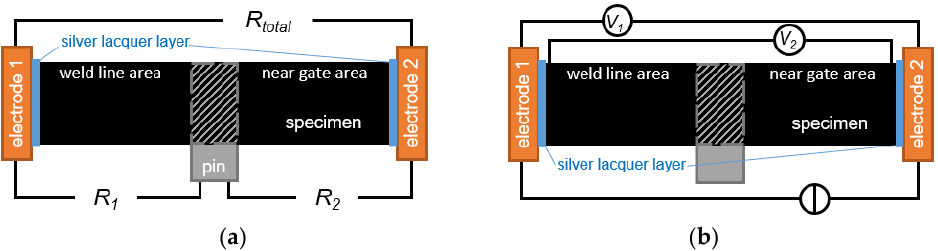
Figure 5. Schematics of the measurement setups in side view: ( a ) of the resistance measurements and ( b ) of the silver lacquer layer evaluation.